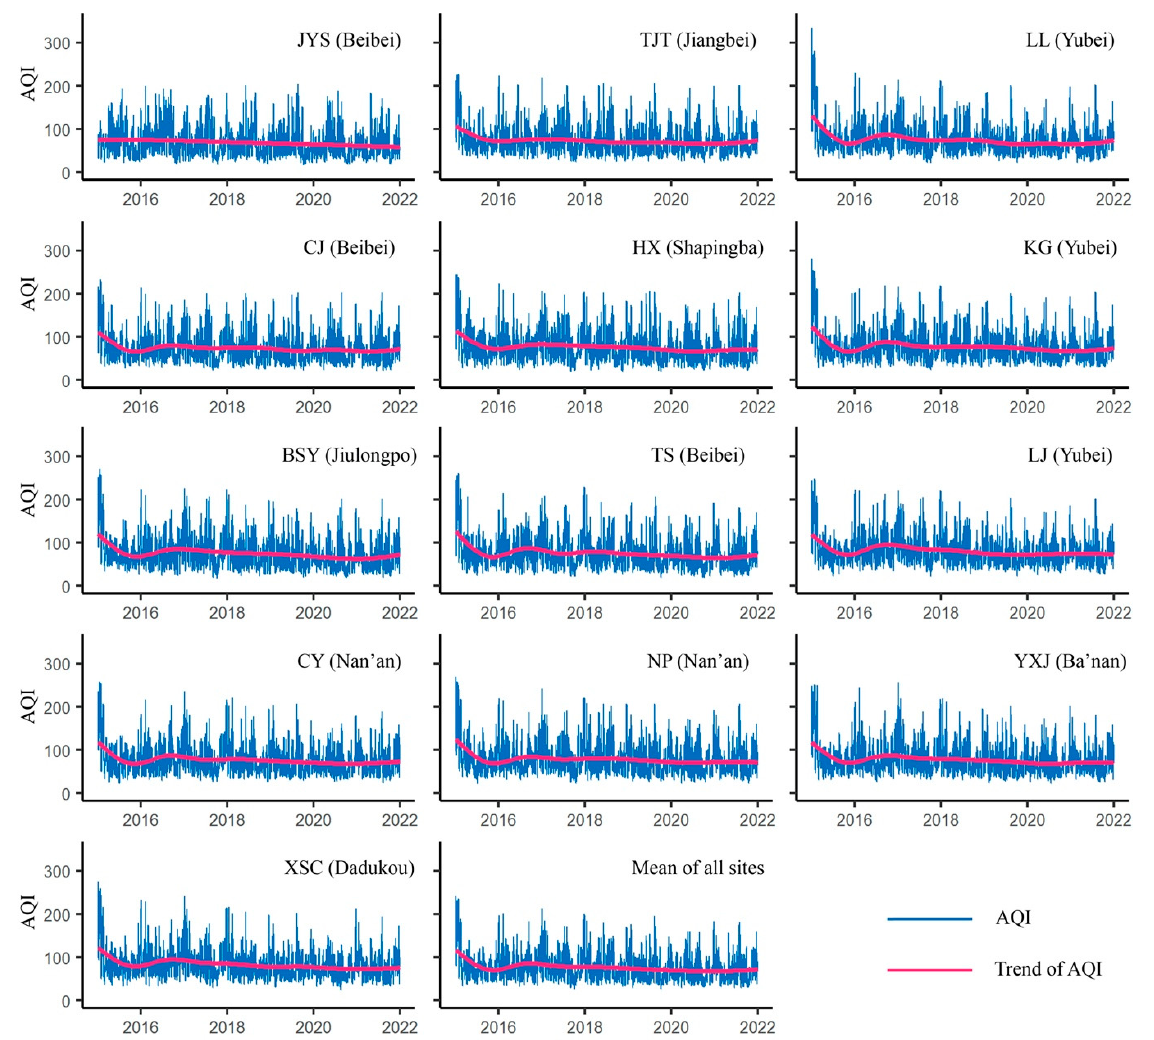
Figure 4. Time series changes of daily AQI for each site and mean of all sites between 2015 and 2021.